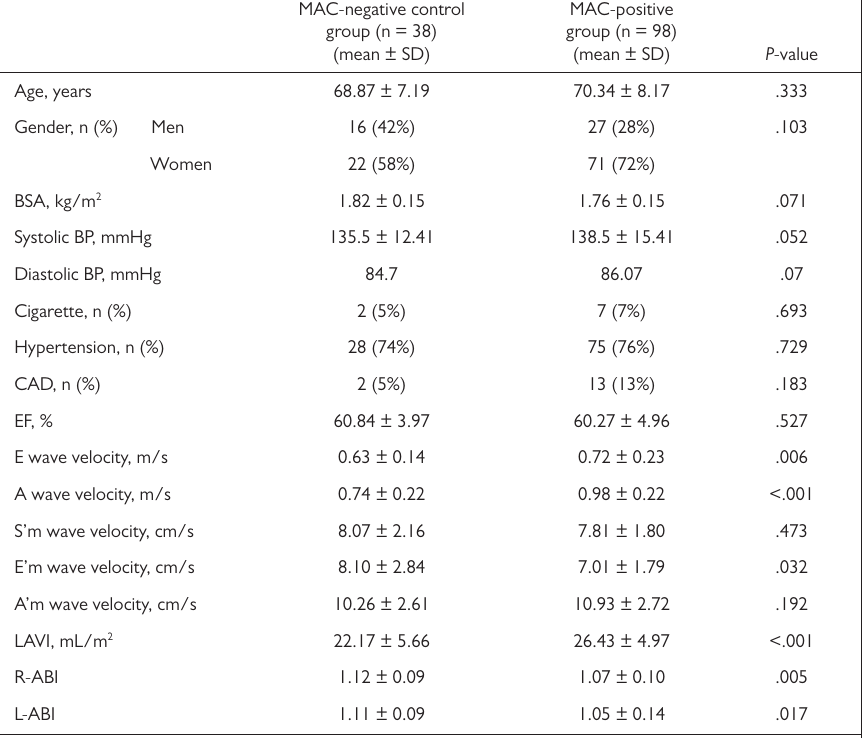
Figure 1. a-c. MAC positivity and echocardiographic grading. Grade 1 (mild, <3 mm thick, including less than one-third of the annulus), Grade 2 (moderate, 3–5 mm thick, less than two-thirds of the annulus), and Grade 3 (severe, >5 mm thick, intensively calcified annulus). MAC, mitral annular calcification. Table 1. Basic Demographic Characteristics, Echocardiographic, and ABI Parameters in MAC-Positive and Control Group